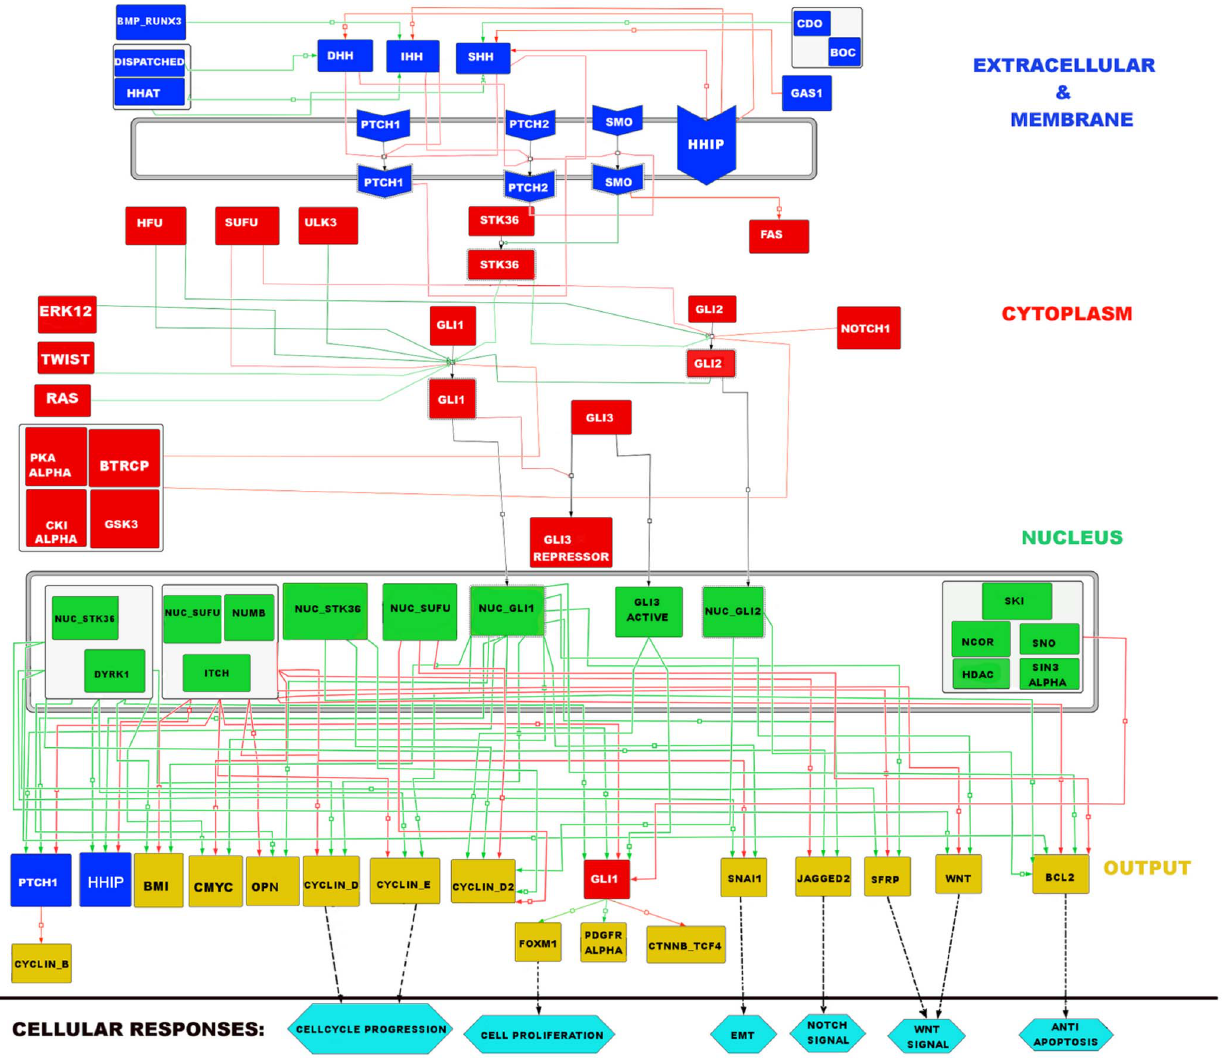
Figure 1. Reconstructed Hedgehog Pathway. Total 57 proteins included in this pathway figure. The green and red arrows are indicating Activation/Production and Inhibition process respectively. The black arrows indicate the nuclear translocation process. All the proteins of this network are allocated into four main regions with different color codes: Extracellular and Membrane (Blue); Cytoplasm (Red); Nucleus (Green); and Output (Yellow). The output proteins are linked with various cellular responses (cross talk with other pathways or phenotypic expressions) with black dotted arrow.